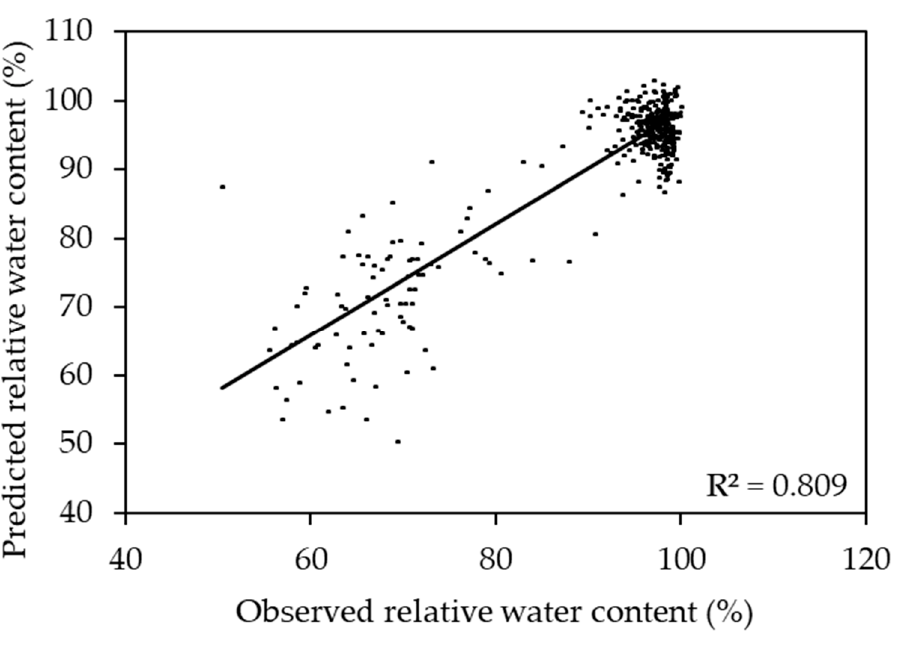
Figure 2. Scatter plot of observed vs. predicted relative water content using the sorghum- and corn-based model.